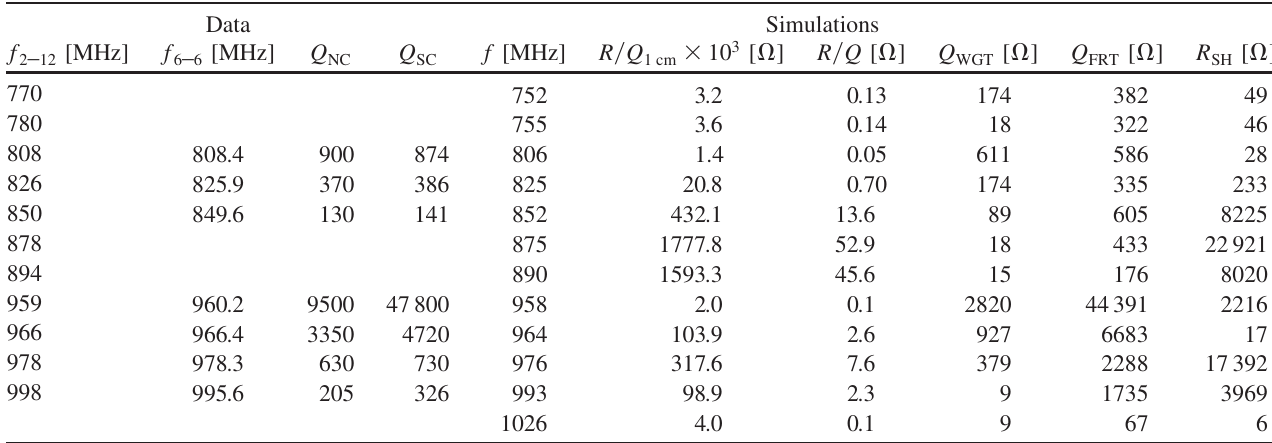
TABLE I. Dipole modes in the R&D ERL cavity. Q WGT and Q FRT are simulated with a waveguide and ferrite dampers.